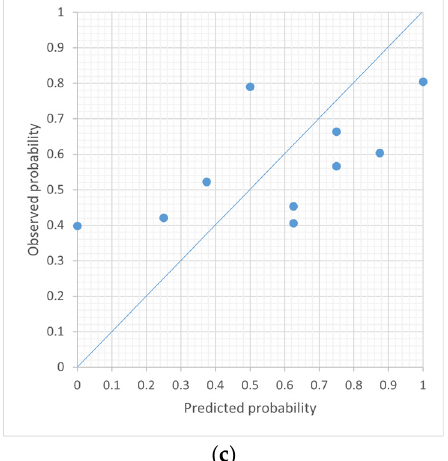
Figure 5. The calibration plots for volume of high, low, and overall opacity. The Hosmer–Lemeshow goodness of fit between the measured and predicted values showed that volume of low opacity ( p = 0.056) ( b ) was higher than volume of high opacity ( p = 0.022) ( a ) and overall opacity ( p = 0.021) ( c ).